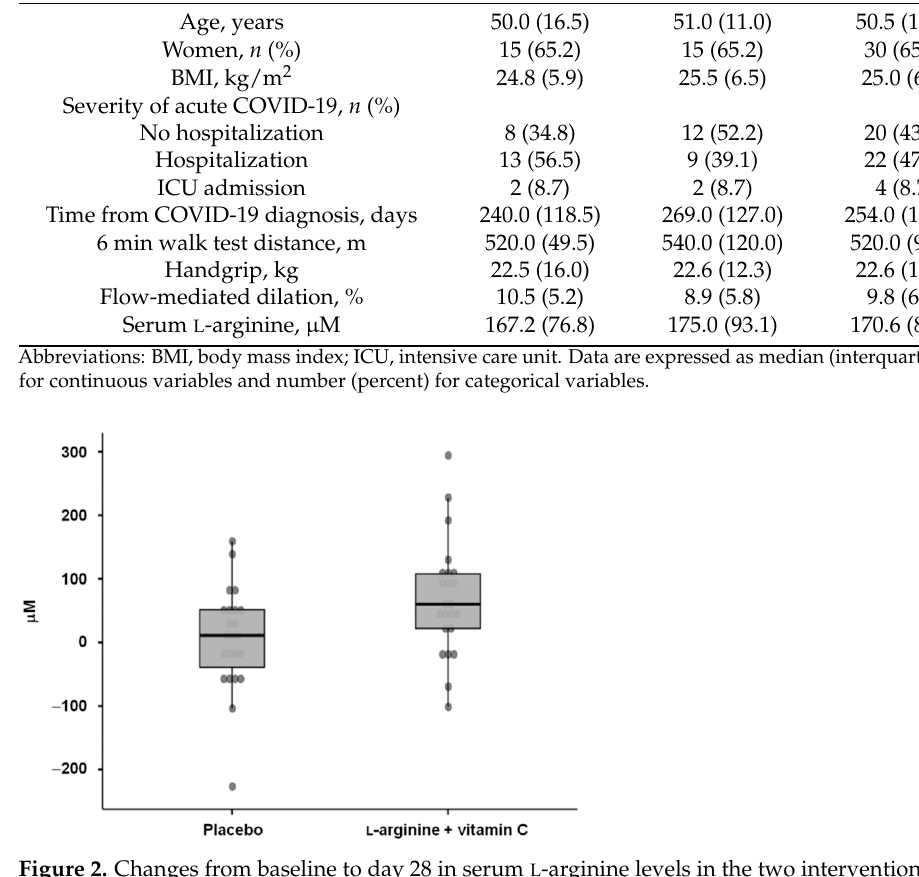
Figure 2. Changes from baseline to day 28 in serum L -arginine levels in the two intervention groups. L -arginine plus vitamin C supplementation was safe and well tolerated, and no